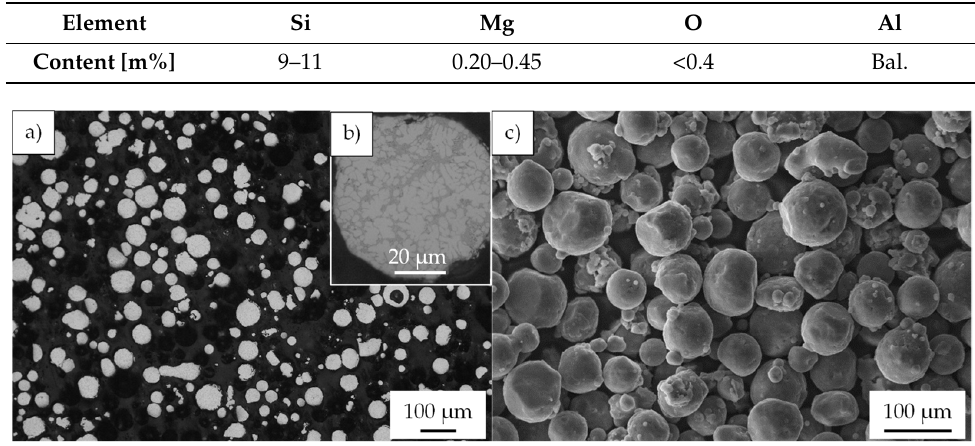
Table 1. Chemical composition of AlSi10Mg alloy according to the datasheet of the manufacturer.